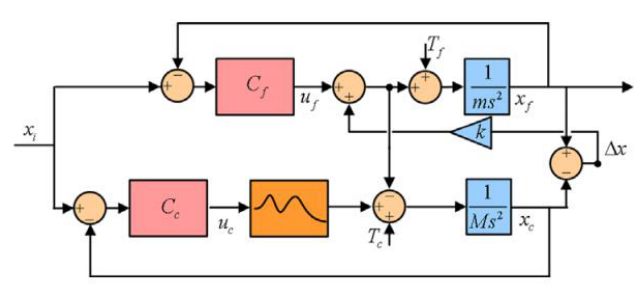
Figure 3. The MISP control diagram with pile-up control strategy.